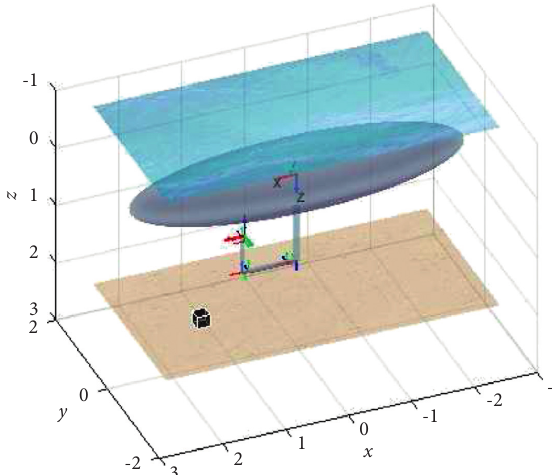
Figure 9: UVMS initial